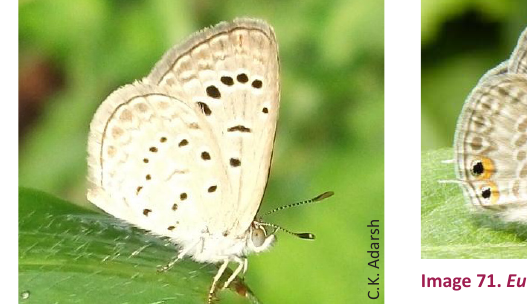
CeruleanImage 71. Euchrysopsc nejus Gram Blue.